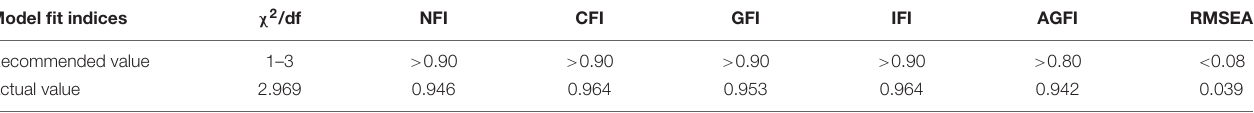
TABLE 4 | Fit indicators of the structural models.